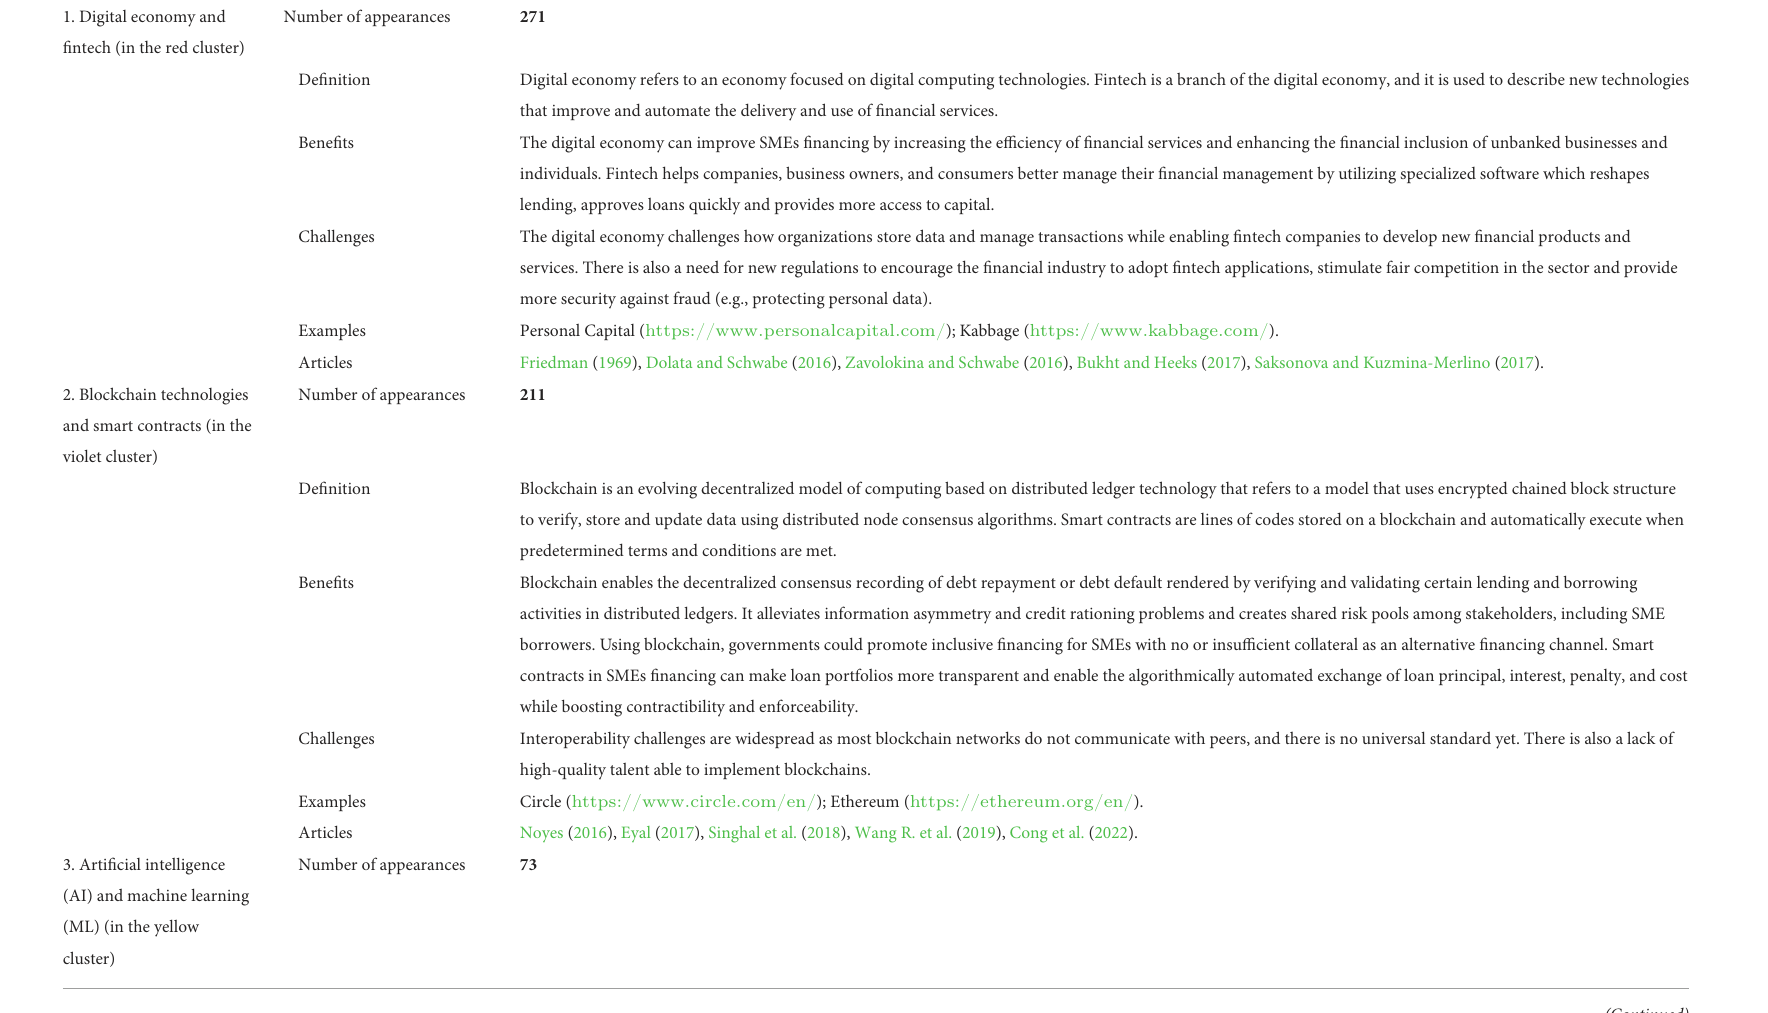
TABLE 1 Major elements of SME financial